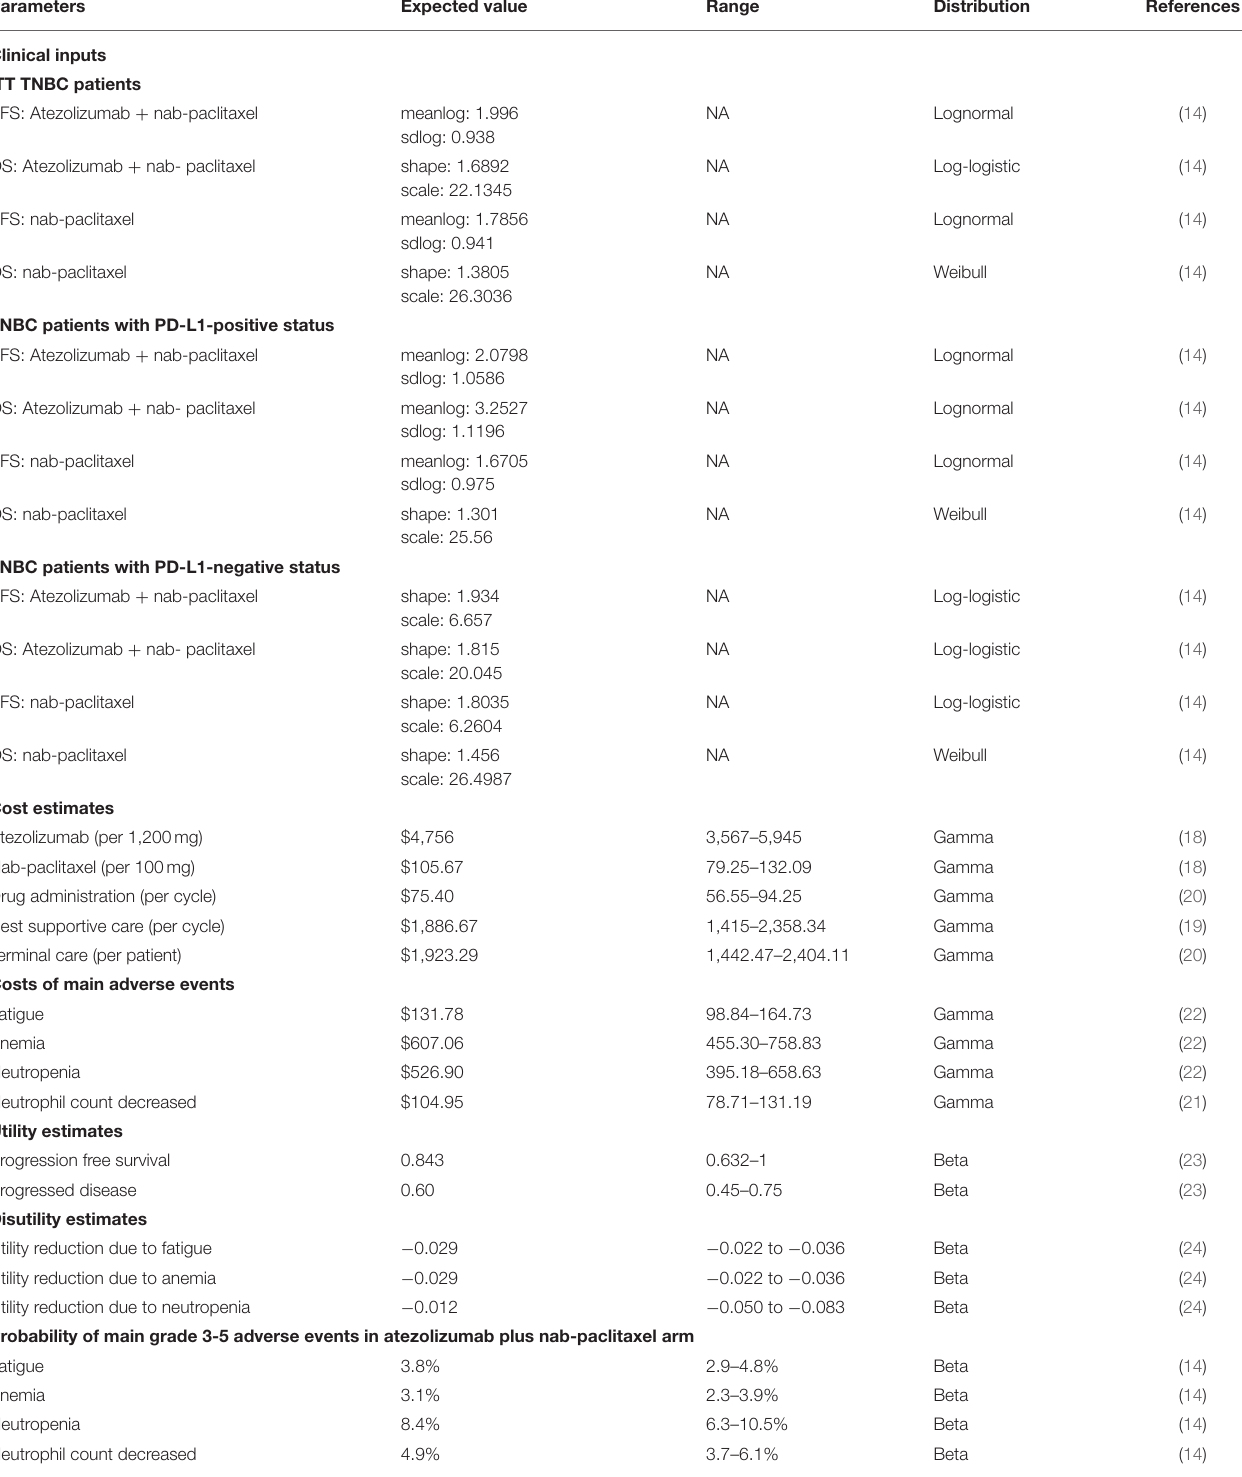
TABLE 1 | Input parameters of the model. Parameters Expected value Range